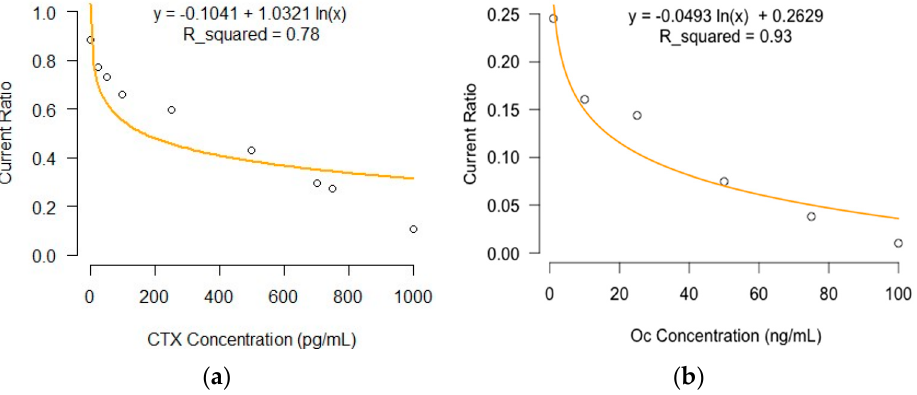
Figure 1. Calibration curve plotted based on the electrochemical response studies of the Osteokit as a function of ( a ) CTX concentration (1–1000 pg/mL); and ( b ) Oc concentration (1–100